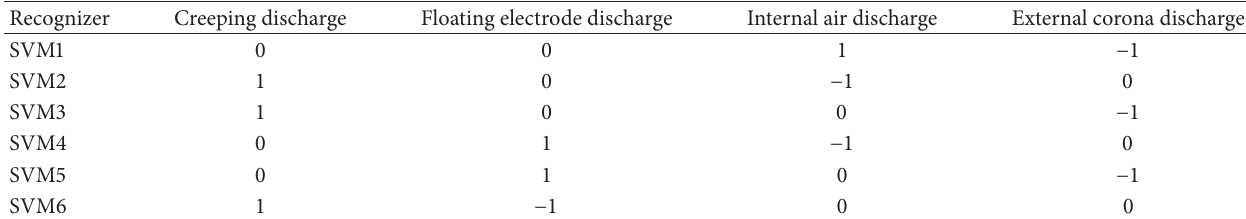
Table 3: Determine the discharge type by vote.